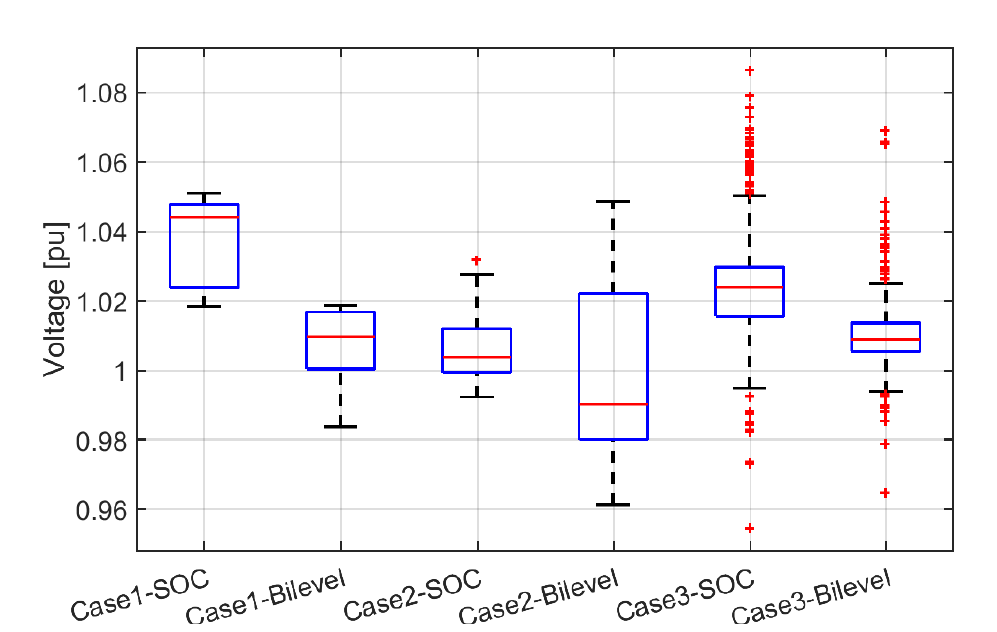
Figure 1. Distribution of bus voltages calculated by SOC-OFD and bi-level-OFD models, for the three case studies. The horizontal red lines show the median of the bus voltages in the network.